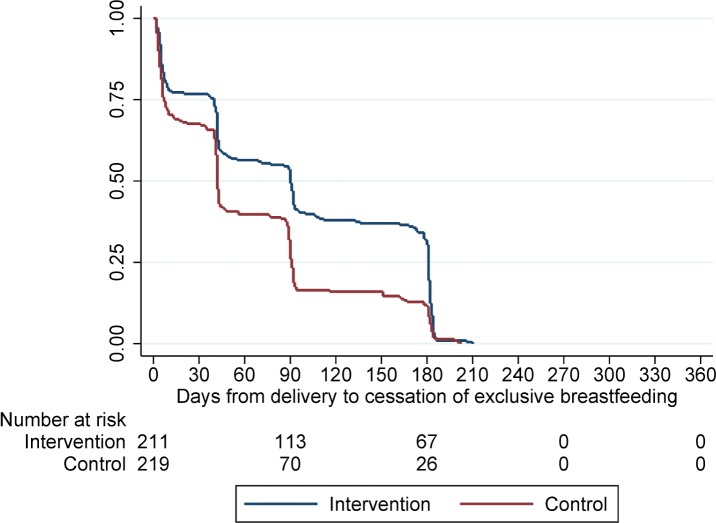
Time to cessation of exclusive breastfeeding for women in the intervention and control arms.Log-rank, p < 0.001.